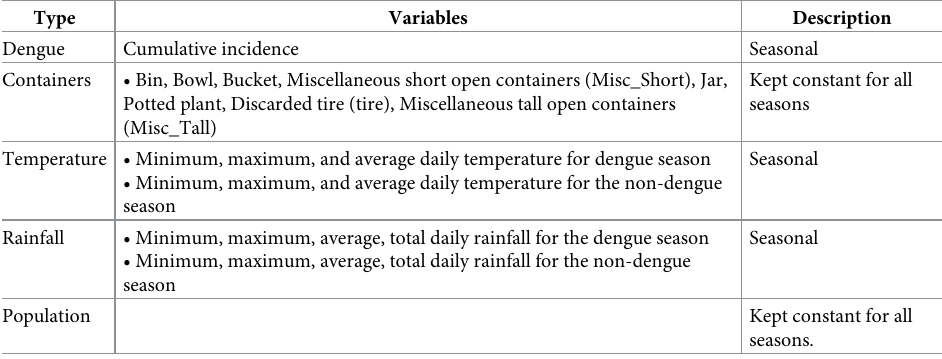
Table 1. List of candidate variables in the dataset.